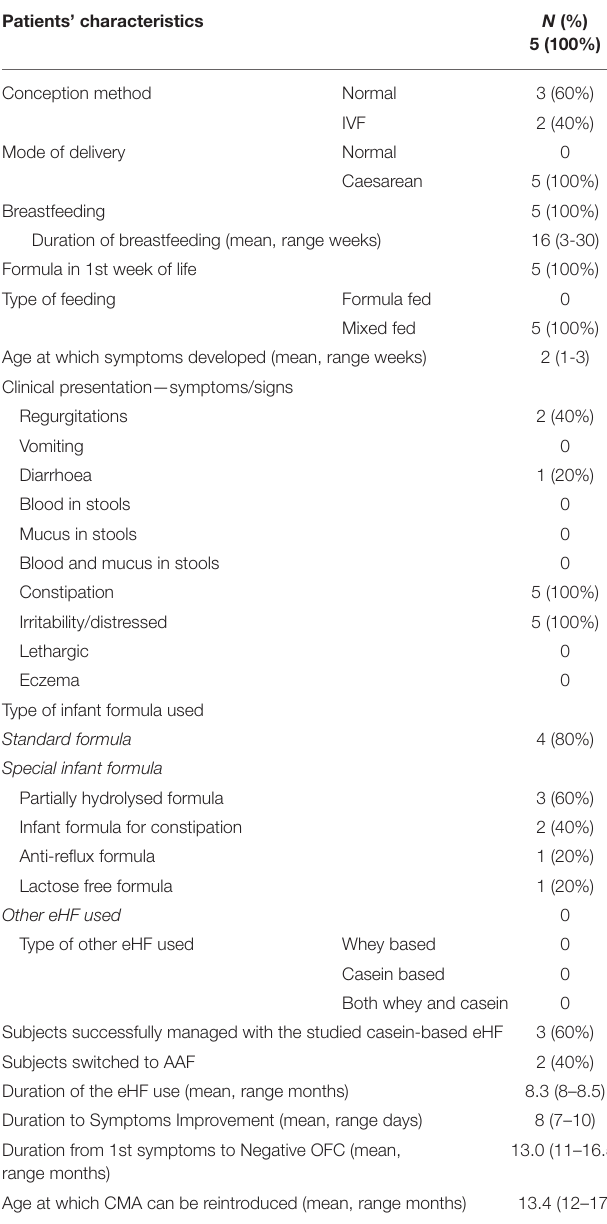
TABLE 3 | Characteristics of patients with constipation due to suspected CMPA. Patients’